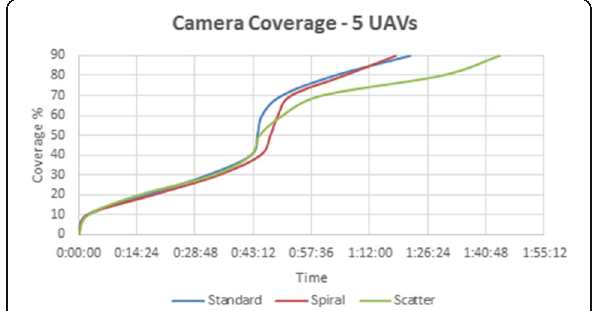
Fig. 11 Average percentage of survivors found over time, referred to as camera coverage, by a swarm of five UAVs across six simulation runs. Scatter method was the slowest and spiral method the fastest to reach the goal of 90%. The jump in coverage just after 43 min occurs when the swarm encounters an evacuation center such as a school in which many survivors are